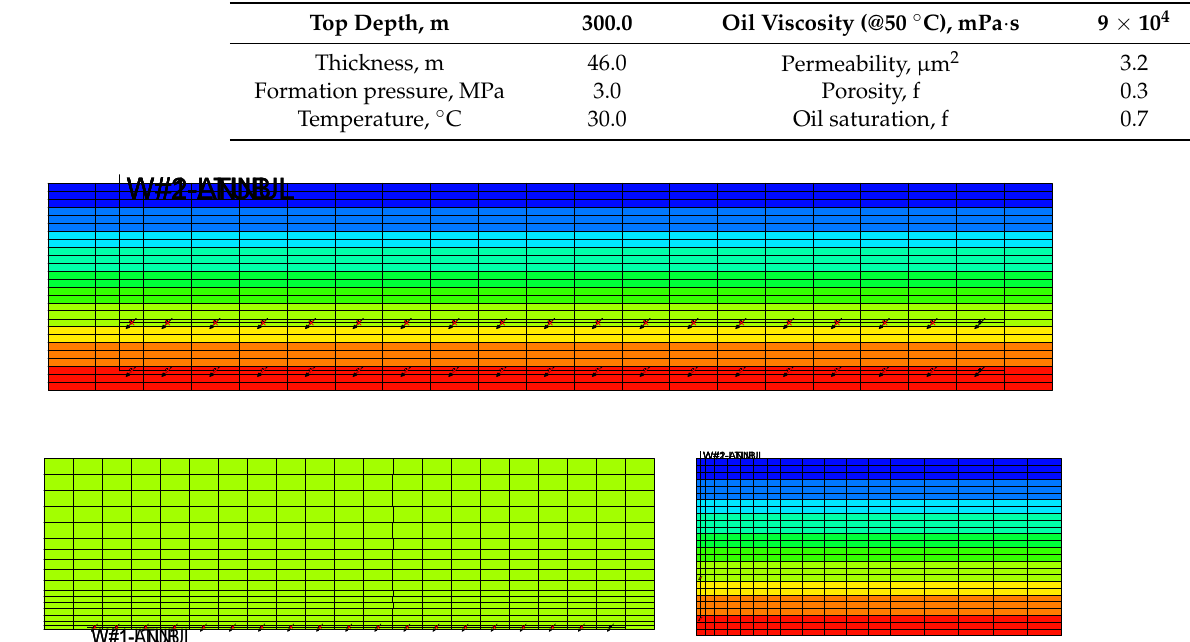
Figure 9. Typical SAGD electrical preheating numerical model.